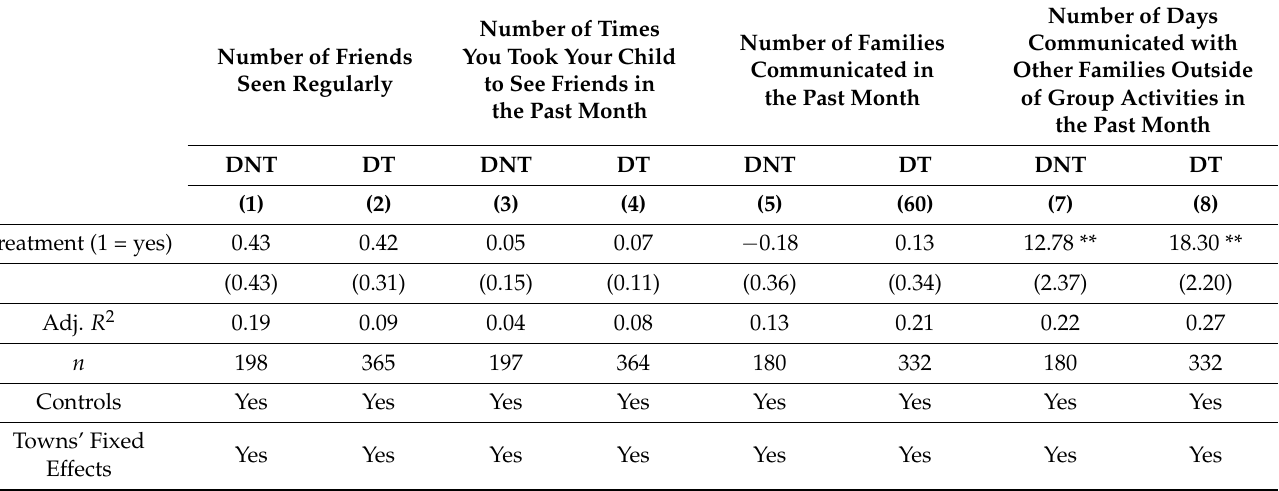
Table 8. Program effect on the social interactions of the